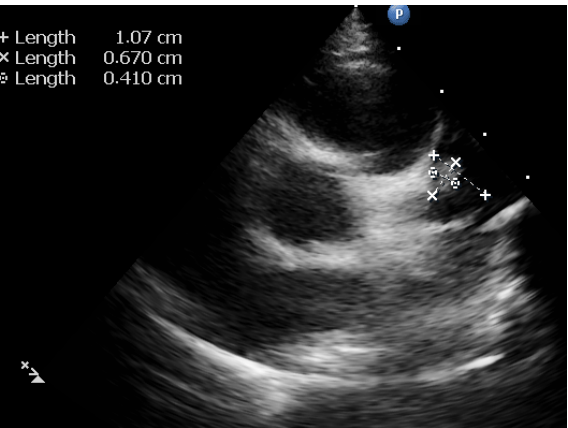
Figure 3. Parasternal short axis. Origins of the coronary arteries with dilation of the anterior descendent artery (white arrow).